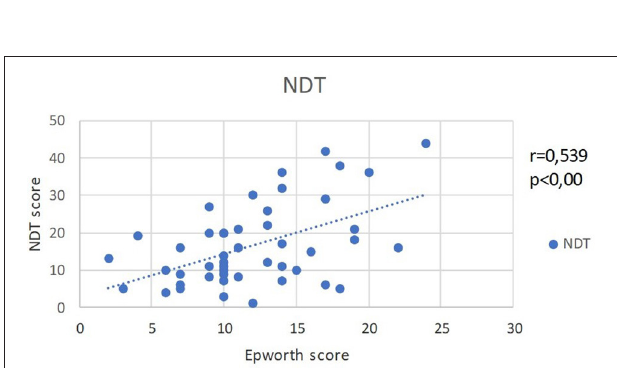
FIGURE 4 | A moderate straight correlation is evident between EES and NDT scores among OSA patients.